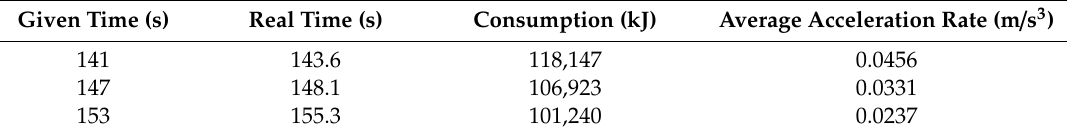
Table 6. Detailed data for comparison.